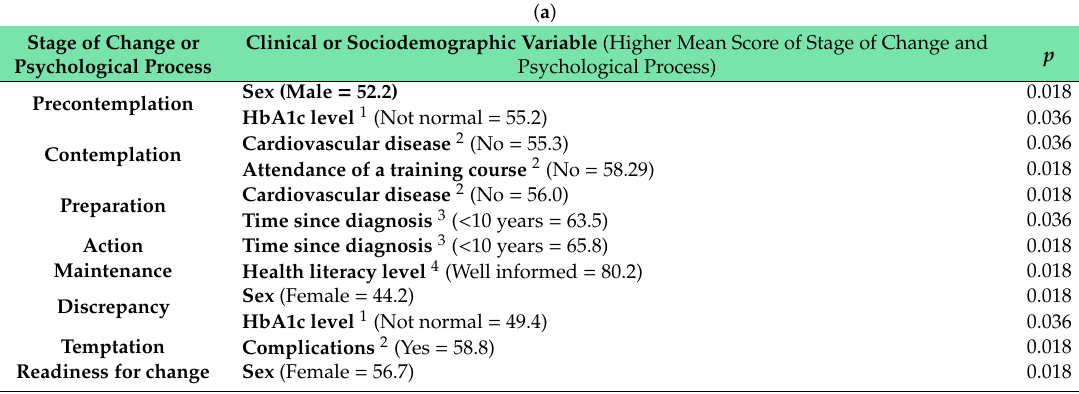
Table 3. ( a ) Stages of change or psychological processes and clinical or sociodemographic variables showing significantly di ff erent mean scores in the domain of nutritional habits. ( b ) Stages of change or psychological processes and communication or interaction variables showing significantly di ff erent mean scores in the domain of nutritional